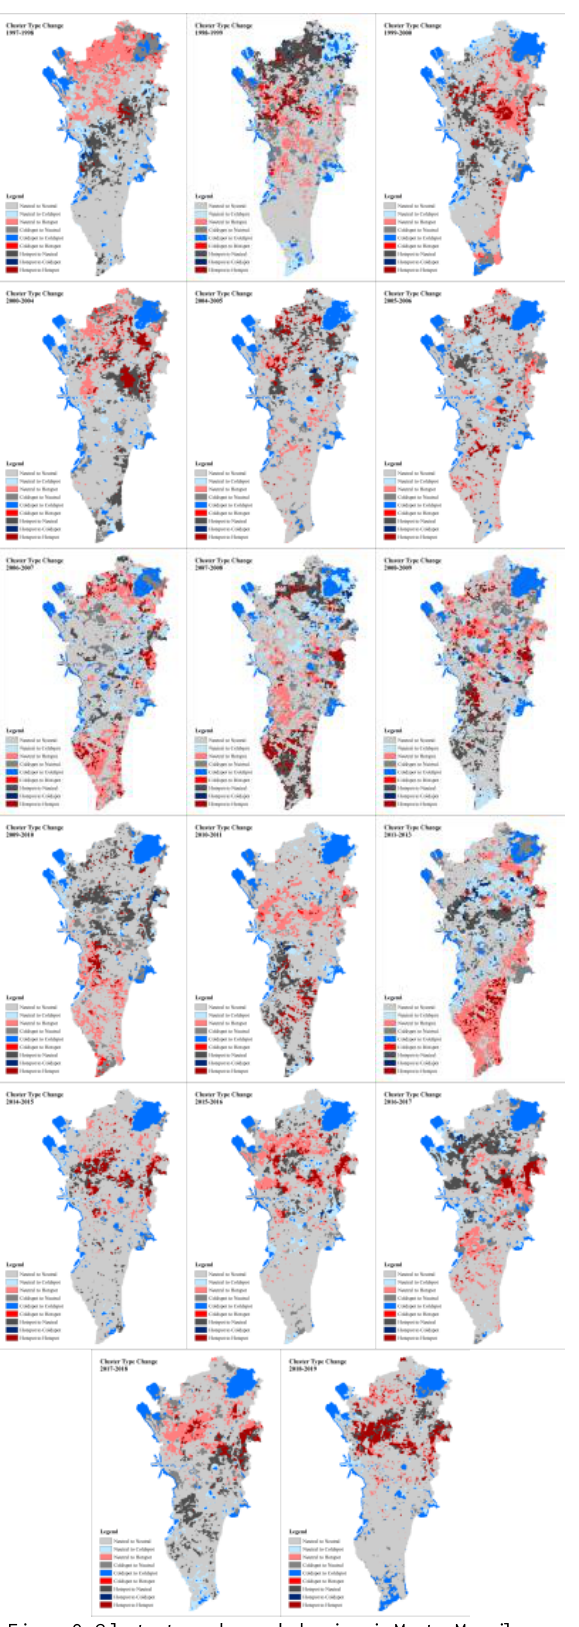
Figure 9. Cluster type change behaviors in Metro Manila per year pair (left to right, top to bottom: 1997-1998 to 2018-2019). neutral (no change), neutral to coldspot, neutral to hotspot, coldspot to neutral, coldspot (no change), coldspot to hotspot, hotspot to neutral, hotspot to coldspot, and hotspot (no change).